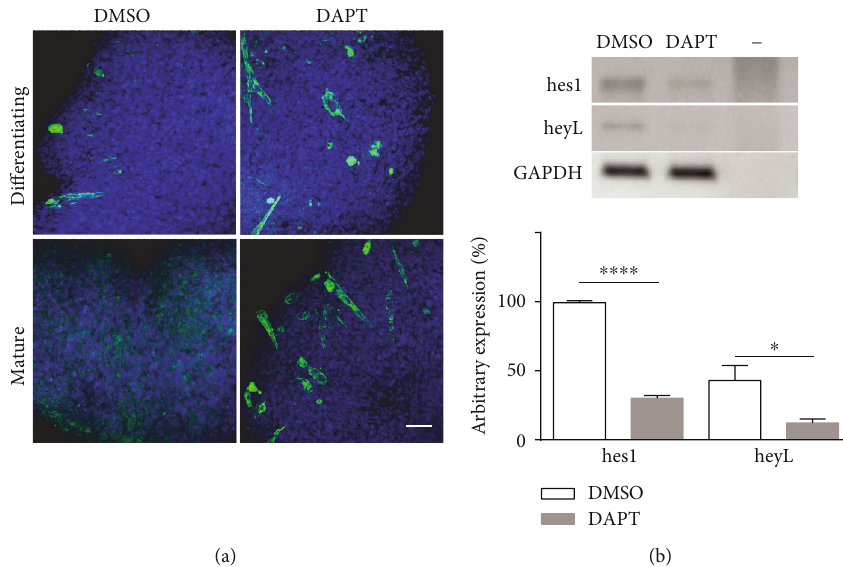
Figure 7: Di ff erentiation resumes in mature myospheres following inhibition of the notch pathway. (a) Confocal image of whole-mount myosin immuno fl uorescence on di ff erentiating (9 days) and mature (25 days) myospheres treated for 5 days with DAPT and respective DMSO controls. The e ff ect of notch pathway inhibition is not particularly evident in di ff erentiating myospheres because syncytia continue to leave the myospheres as they are formed. By contrast, DAPT resumes di ff erentiation in mature myospheres, which retain the syncytia. Scale bar: 50 μ m (b) RT-PCR showing the change of hes1 and heyL expression in mature myospheres in response to 5 μ M DAPT treatment. Below the densitometric analysis of hes1 and heyL bands. ∗ 0 : 01 < p < 0 : 05 and ∗∗∗∗ p < 0 : 0001